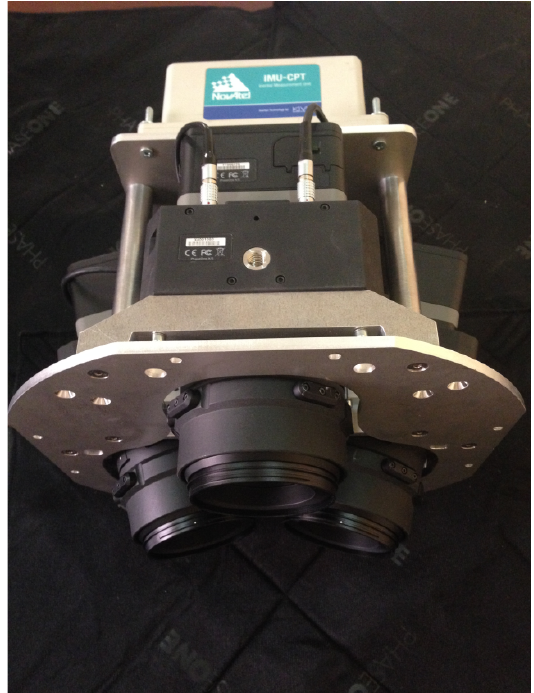
Figure 1: Camera head based on 3 midformat cameras to generate nadir and 2 oblique